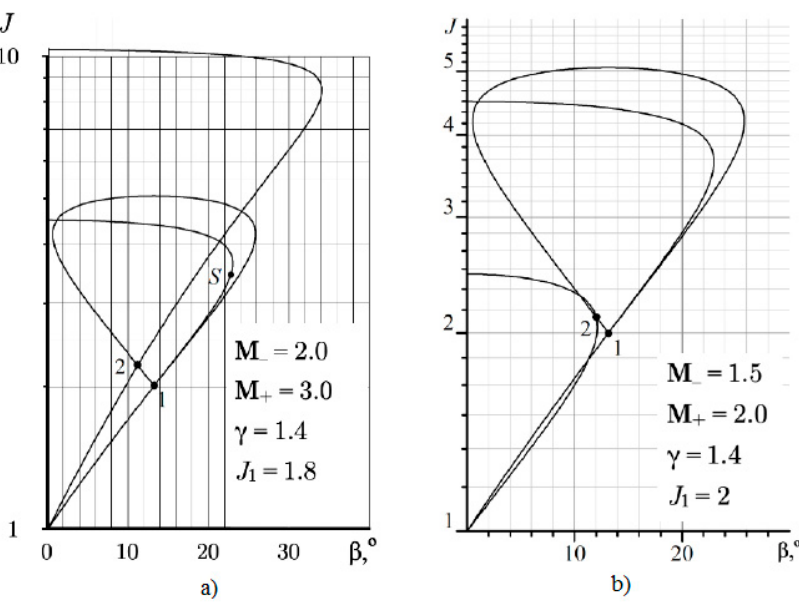
Figure 9. Regular refraction when the flow behind the reflected flow is supersonic ( a ) and subsonic ( b ).